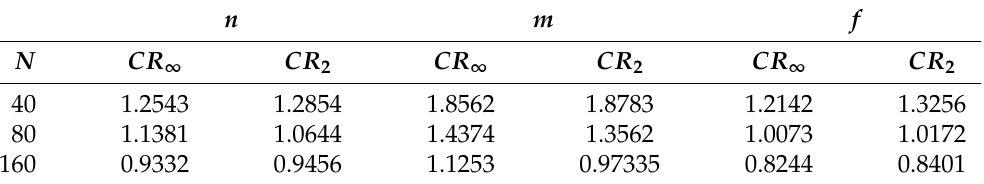
Table 6. Convergence rates of the original problem in different norms, Example 2.